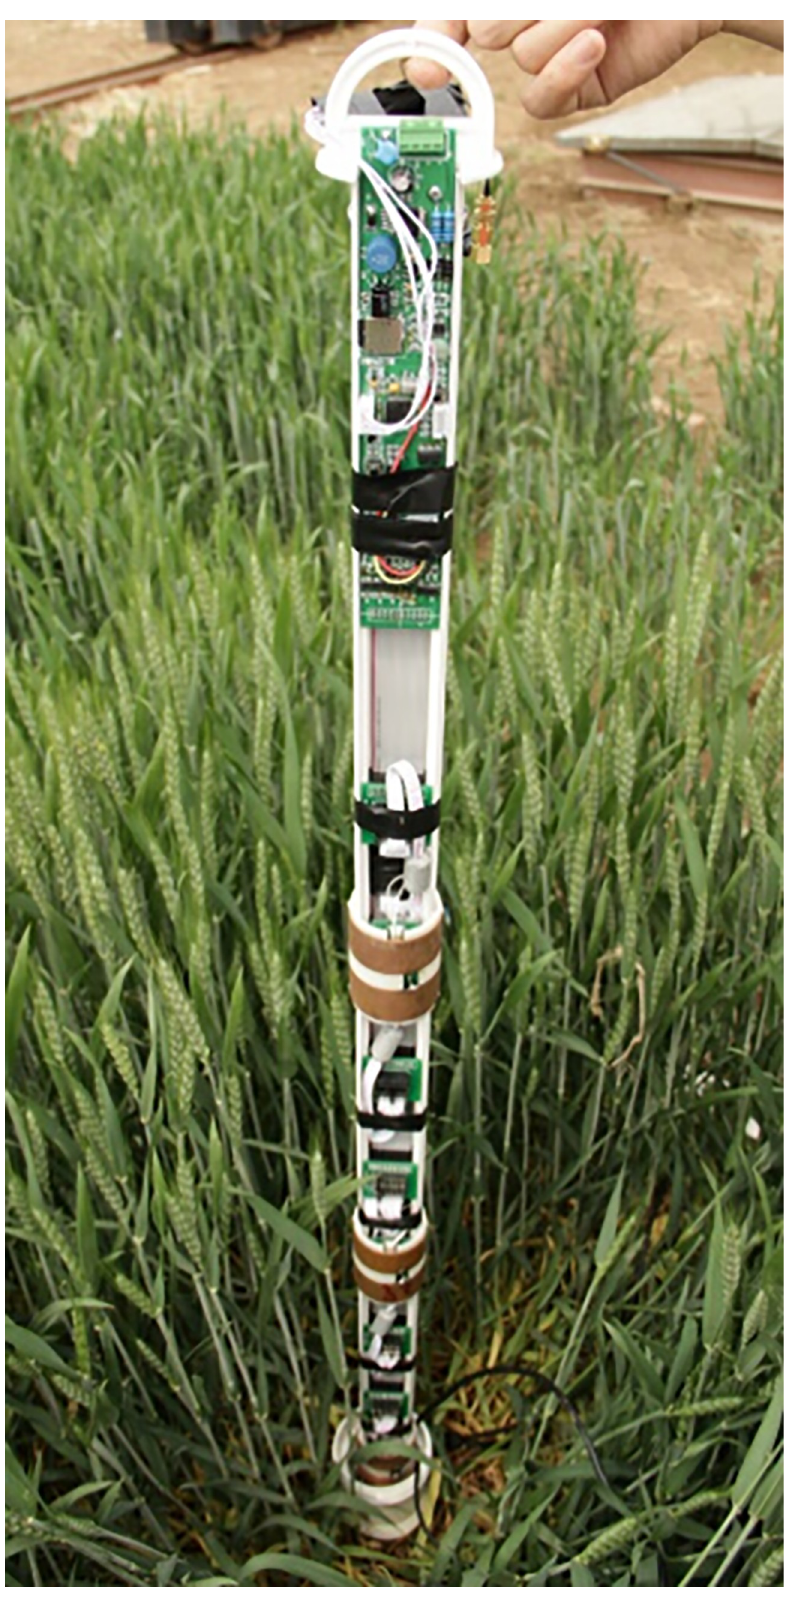
Fig 5. Field ring probe of soil freezing and thawing sensor